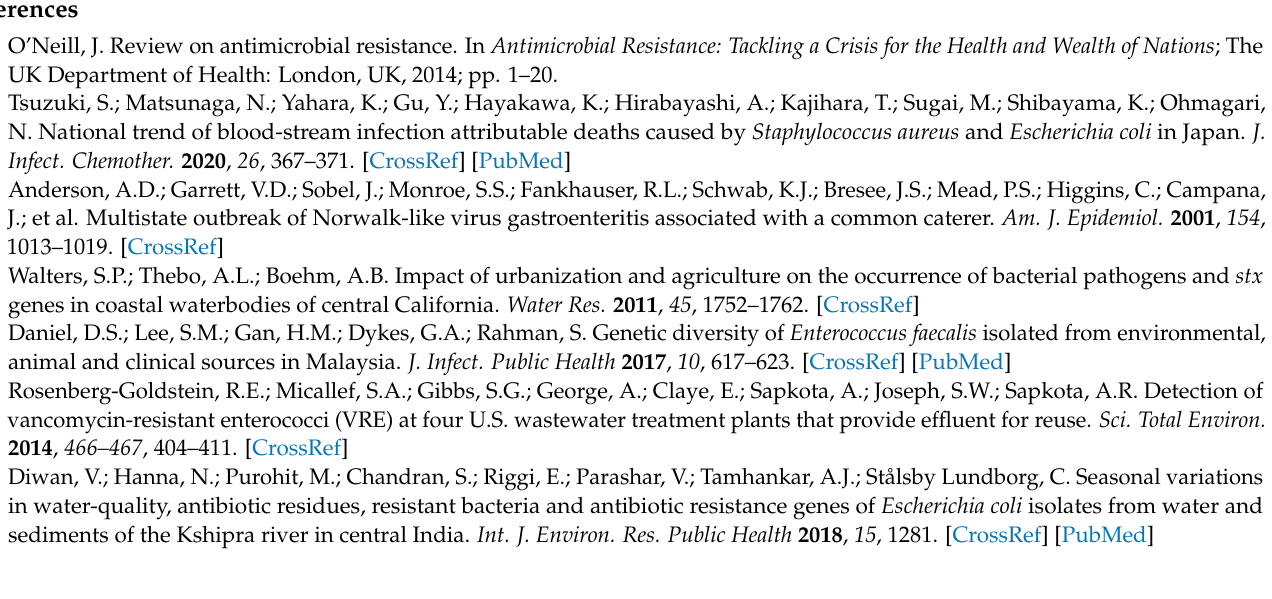
Table S1: Design of primers sequence for detection of phylogroups of E. coli isolates; Table S2: Design of primers sequence for detection of ESBL-producing genotypes of E. coli isolates; Table S3: The parameters of water quality and the number of bacteria in each sample from plant A and B; Table S4: The profiles of antibiotic-resistant E. coli isolates in each sample from plant A and